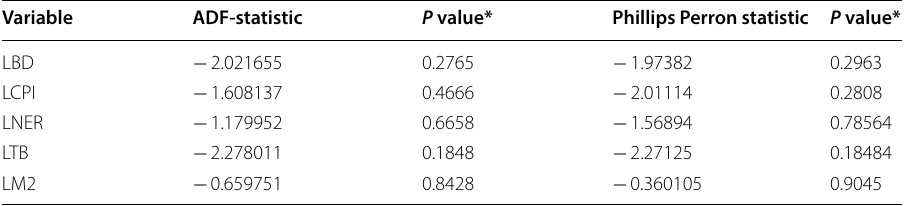
Table 1 The correlation matrix of the study variables Source : Correlation Output from Eviews 7 DGDPG DLBD DLCPI DLM2 DLNER DLTB DGDPG 1.000 0.072 0.186 0.170 0.047 0.257 − − − − DLBD 0.071 1.000 0.266 0.026 0.036 0.087 − − DLCPI 0.180 0.269 1.000 0.311 0.087 0.302 − DLM2 0.101 0.026 0.318 1.000 0.493 0.390 − − − DLNER 0.046 0.035 0.087 0.479 1.000 0.316 − − DLTB 0.257 0.058 0.306 0.391 0.315 1.000 − −